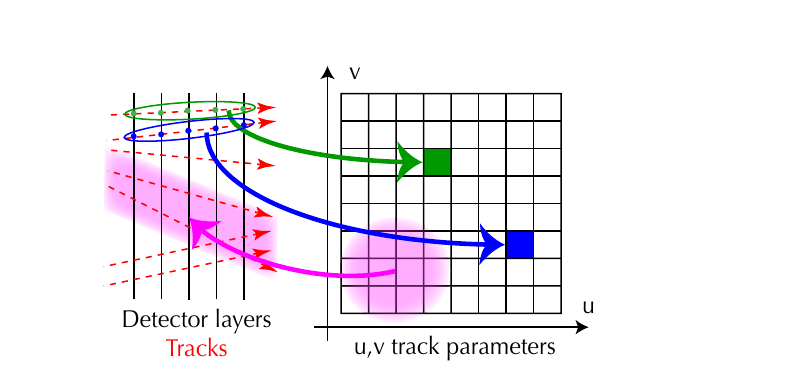
areas of the detector, and this information is recorded in a look-up-table (LUT). A commercial PC is enough to generate the two mappings starting from simulated